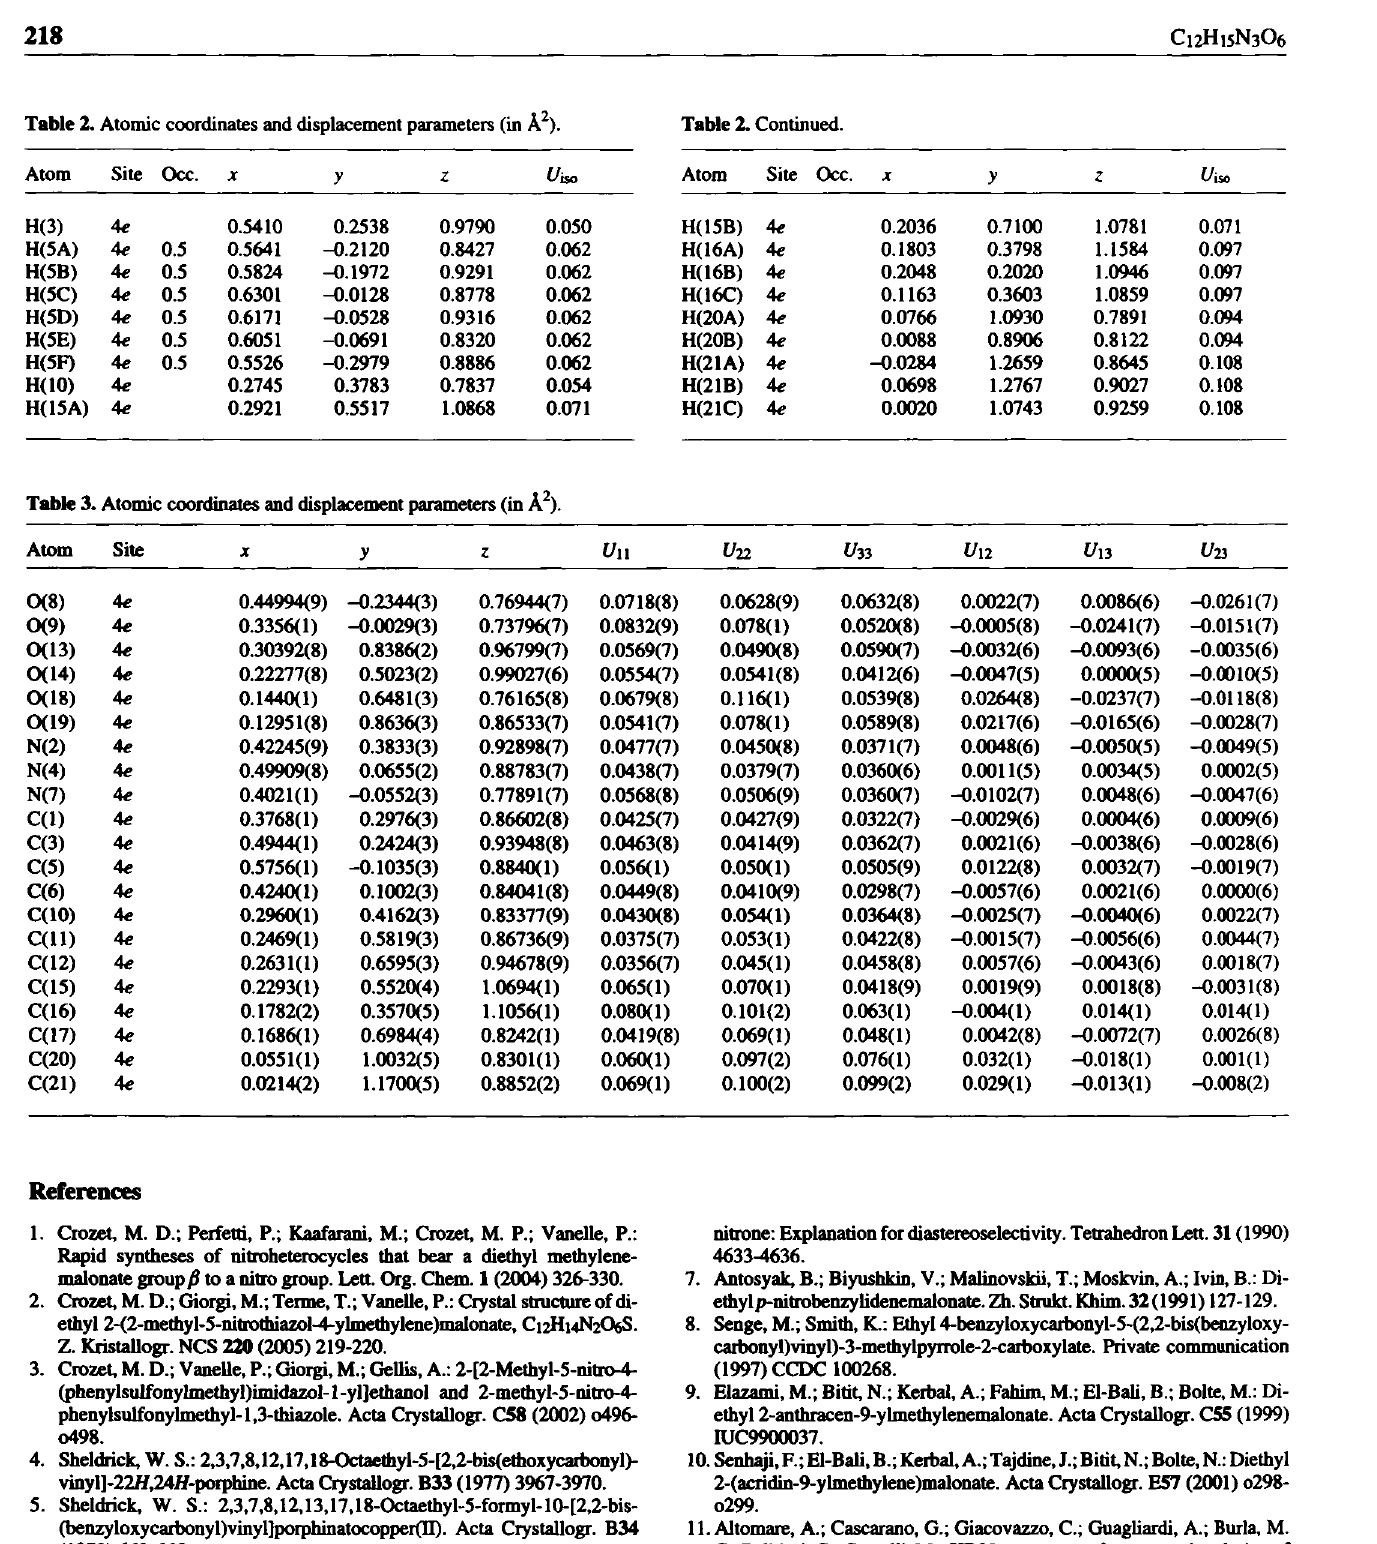
Table 3. Atomic coordinates and displacement parameters (in A 2